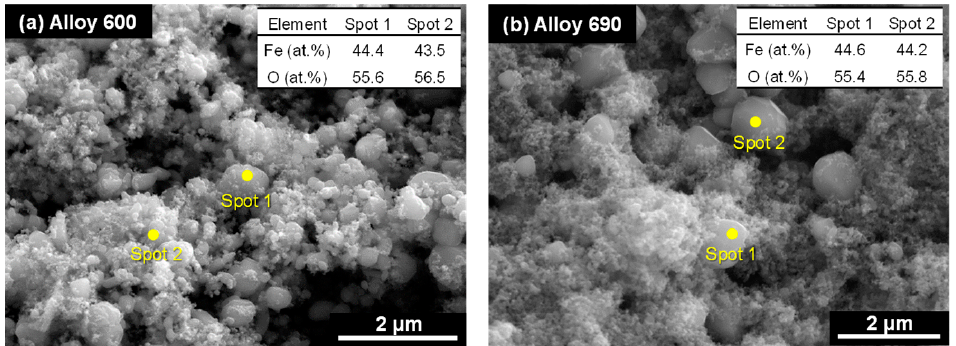
Figure 9. SEM ‐ EDS analysis of deposits of SG tubes: ( a ) Alloy 600 and ( b ) Alloy 690. Figure 9. SEM-EDS analysis of deposits of SG tubes: ( a ) Alloy 600 and ( b ) Alloy 690.